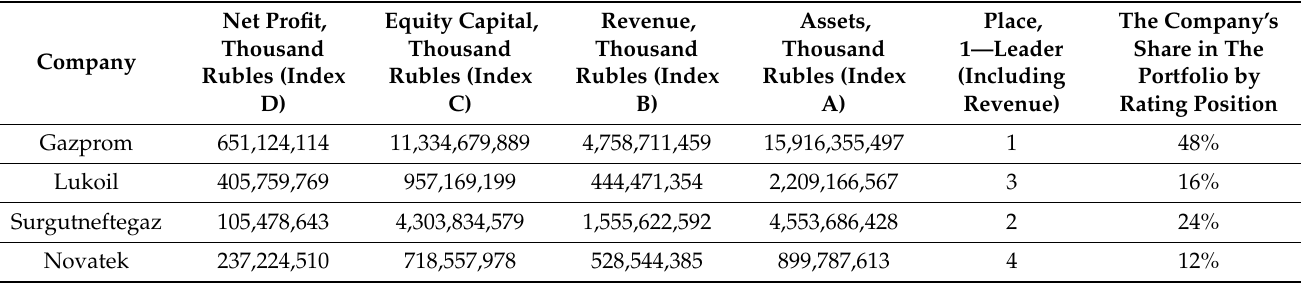
Table 2. Solving the problem (1)–(2) for ratings.